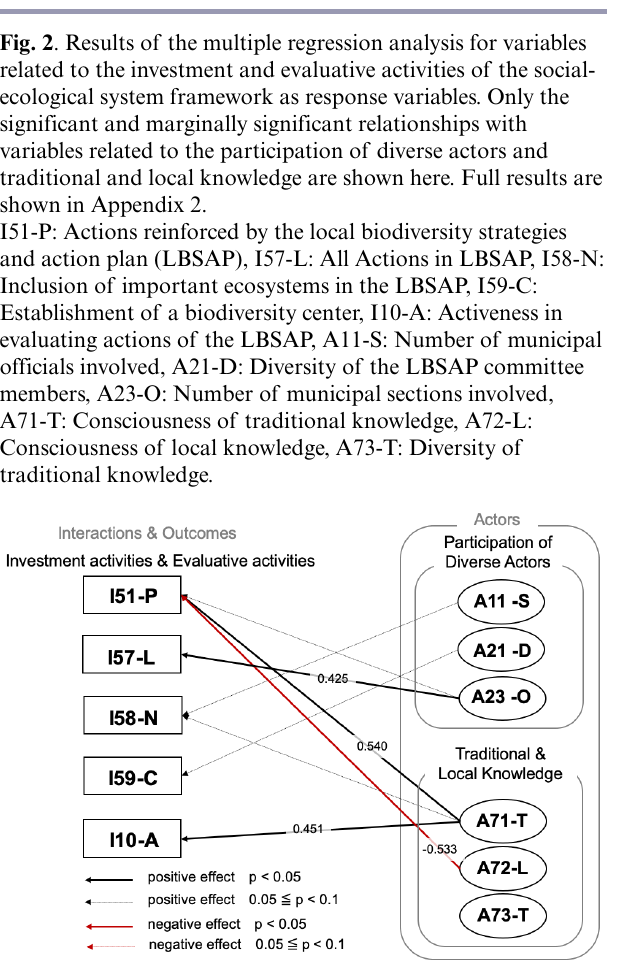
Fig. 2 . Results of the multiple regression analysis for variables related to the investment and evaluative activities of the social- ecological system framework as response variables. Only the significant and marginally significant relationships with variables related to the participation of diverse actors and traditional and local knowledge are shown here. Full results are shown in Appendix